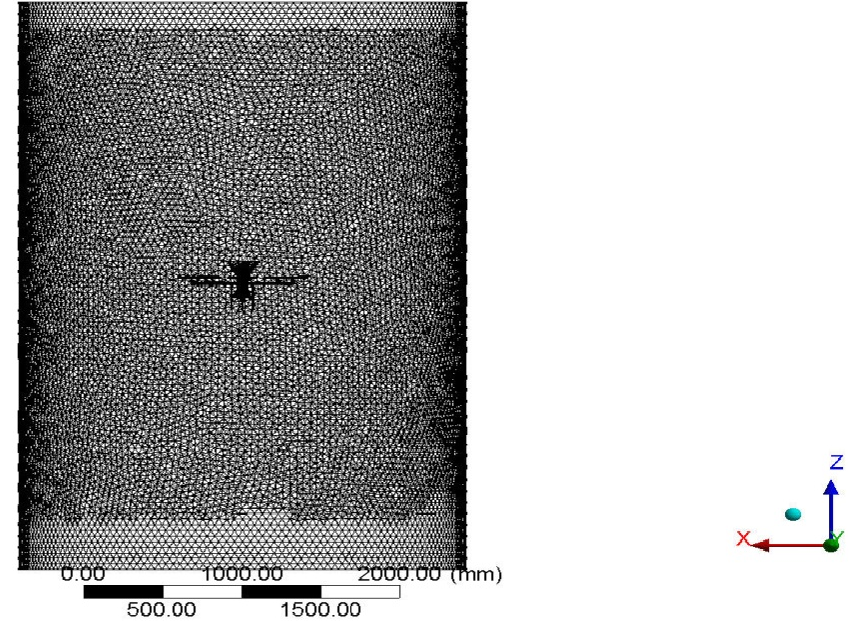
Figure 17. Discretized structure of the entire computational model.